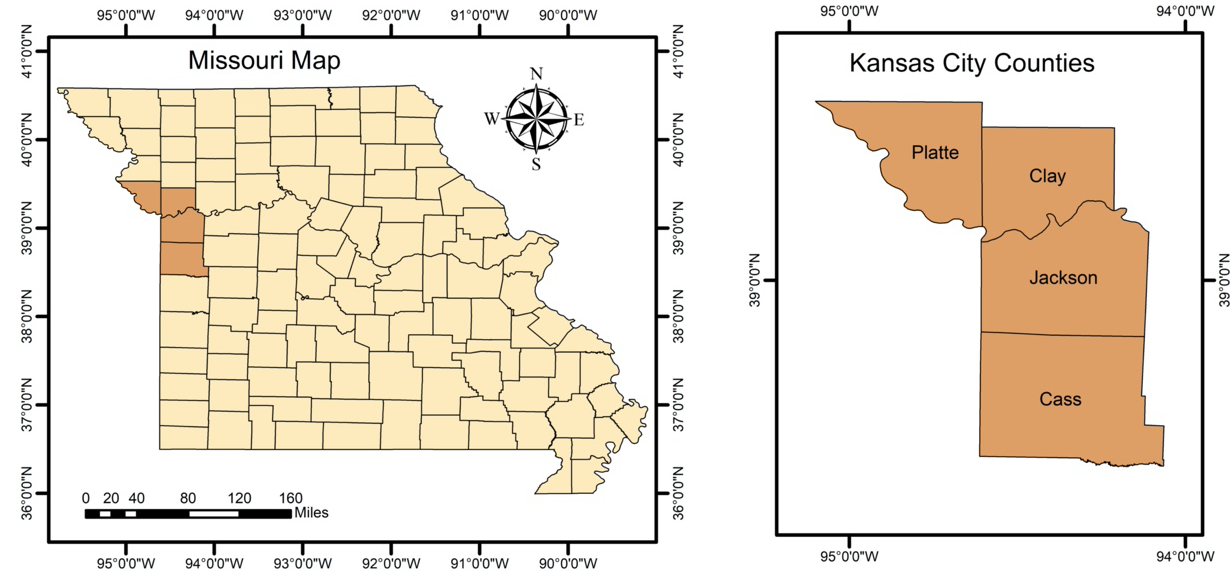
Figure 1. Missouri state map ( left ), Kansas City counties map ( right ) .